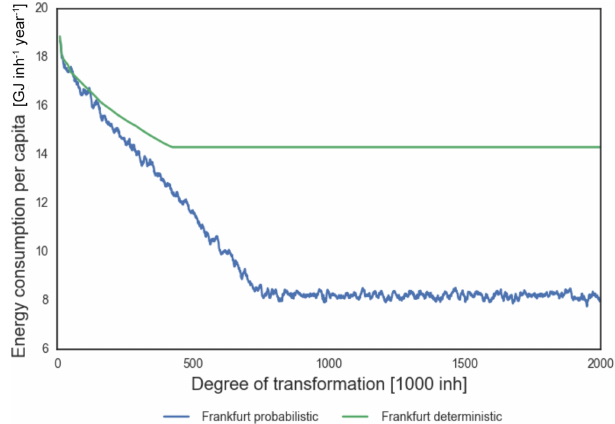
Figure 5. Moving average (five model steps) of the spatial entropy along the model runs minimizing the energy consumption for urban mobility in Frankfurt.